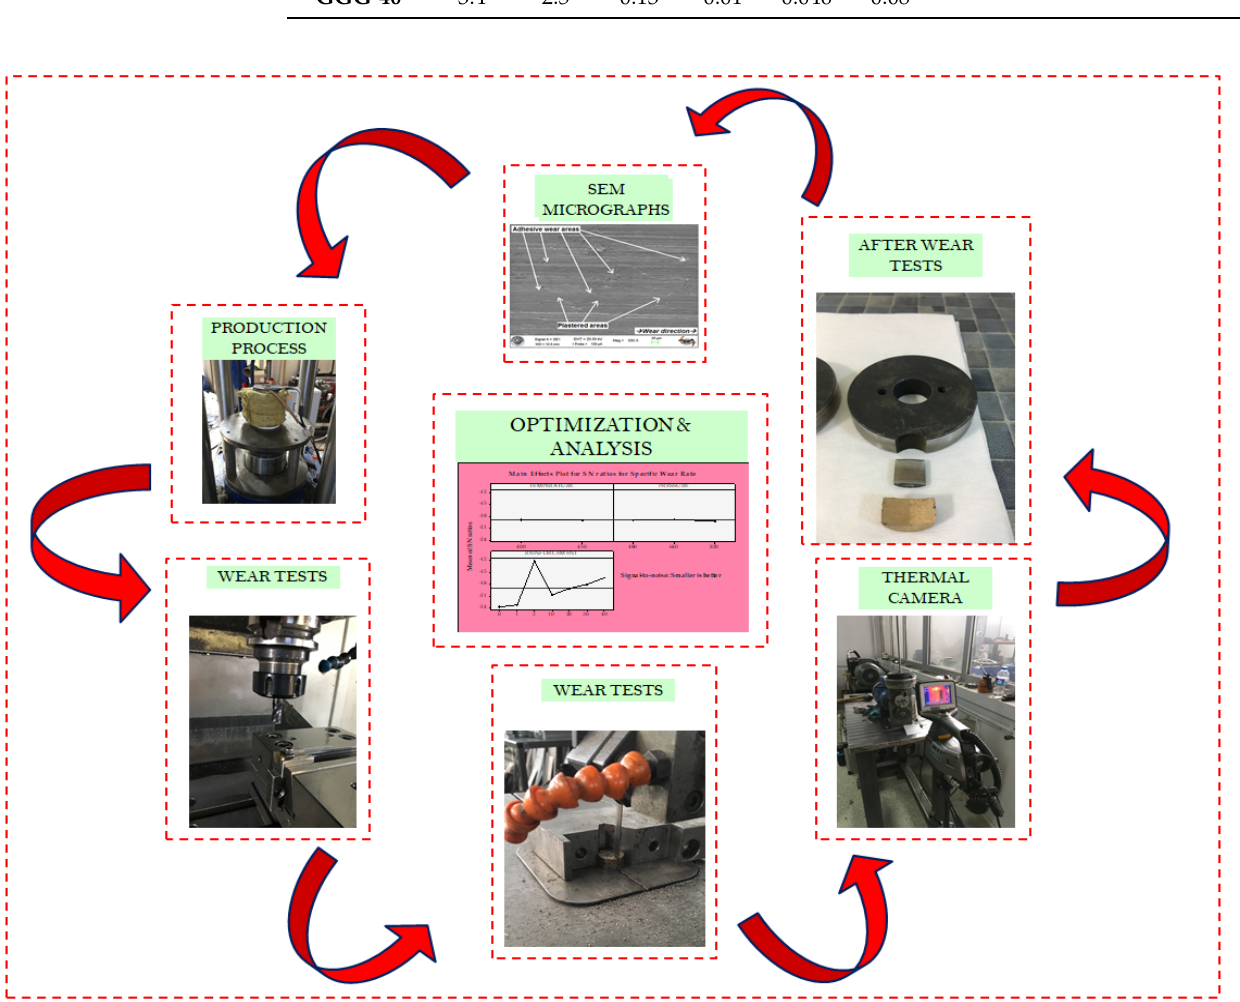
Figure 1. A general outline of the study.